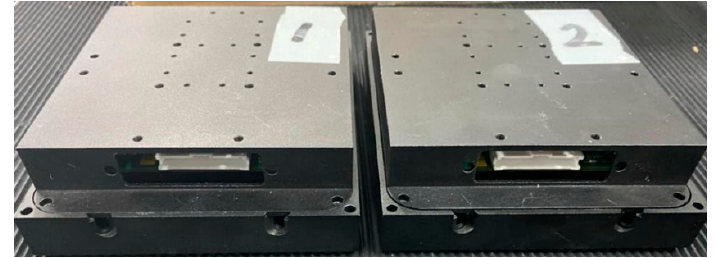
Figure 6. Dummy EDFA units for the preliminary radiation tests.